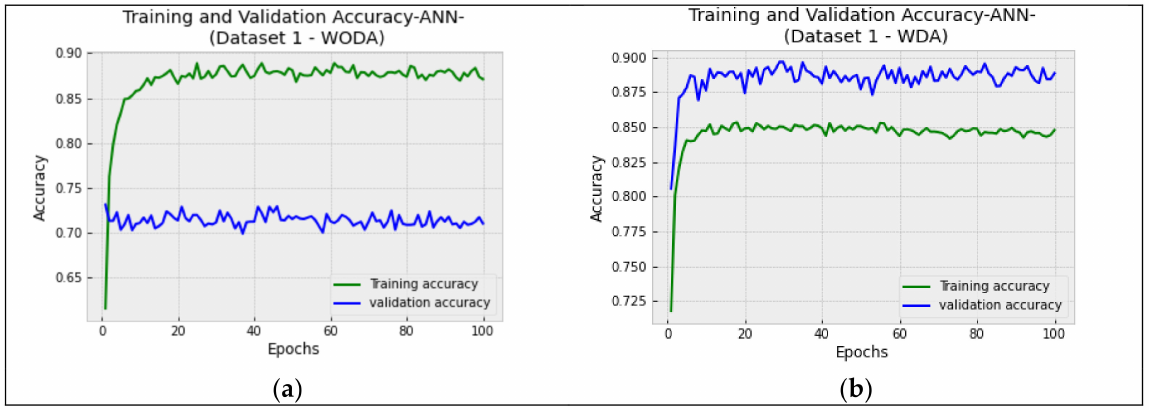
Figure 10. ANN model validation and testing accuracy and loss without data augmentation (dataset 1): ( a ) model accuracy (WODA); ( b ) model accuracy (WDA).